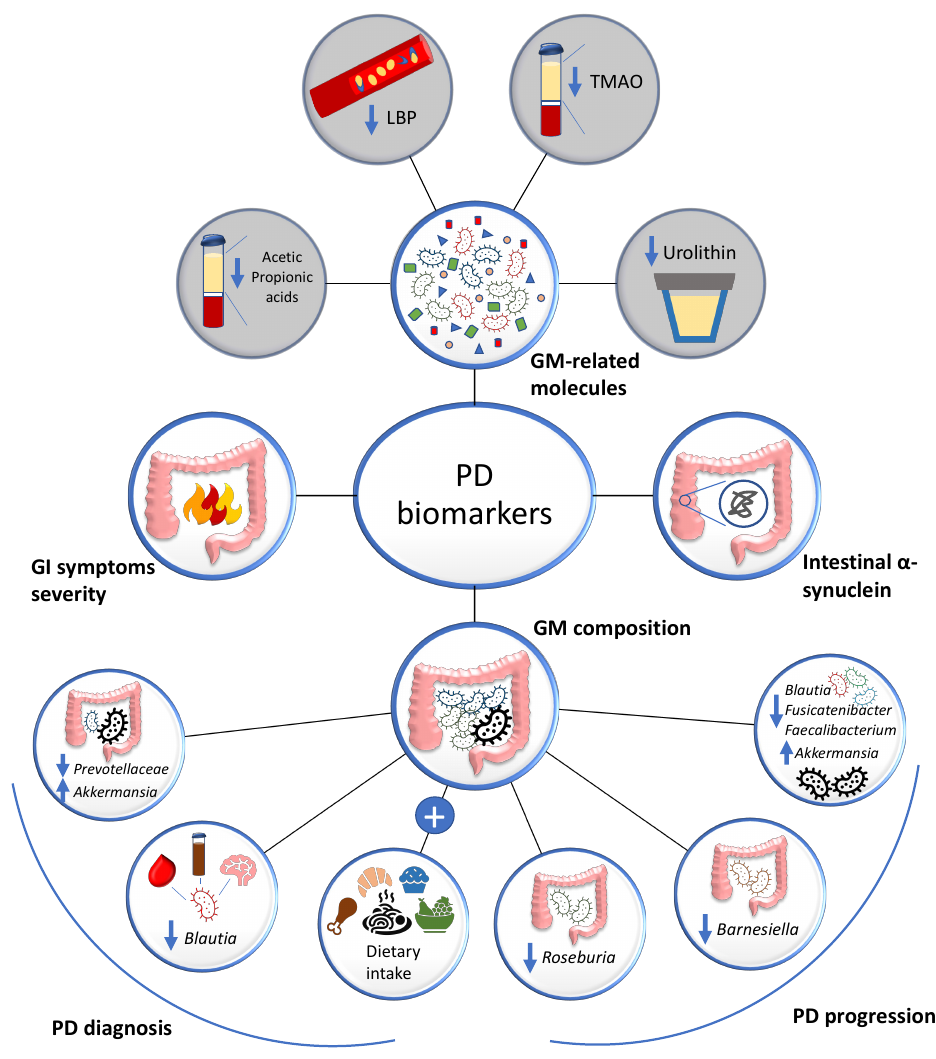
Figure 2. Gut microbiota (GM)-based Parkinson’s disease (PD) biomarkers. Four different traits of the intestine have been proposed as PD biomarkers: intestinal α-synuclein, gastrointestinal (GI) symptoms severity, GM-related molecules, and GM composition. Among GM-related molecules, low levels of urine urolithin, decreased plasma trimethylamine N-oxide (TMAO), reduced plasma acetic and propionic acids and low levels of circulating LPS binding protein (LBP) are associated with PD. Concerning GM composition, while decreased relative abundance of Roseburia , Barnesiella , Blautia , Fusicatenibacter , Faecalibacterium and increased Akkermansia may serve as indicators of PD progression, dysbiosis data alone or associated with dietary intake information are useful for PD diagnosis. ↑ : increase; ↓ :